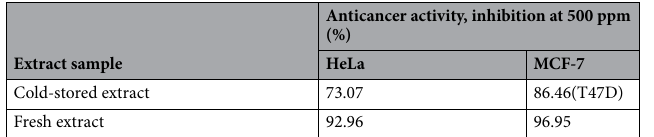
Table 7. Comparison between anticancer inhibition at 500 ppm of freshly prepared and stored X. granatum leaves extract against HeLa and breast cancer cells (MCF-7 and T47D).